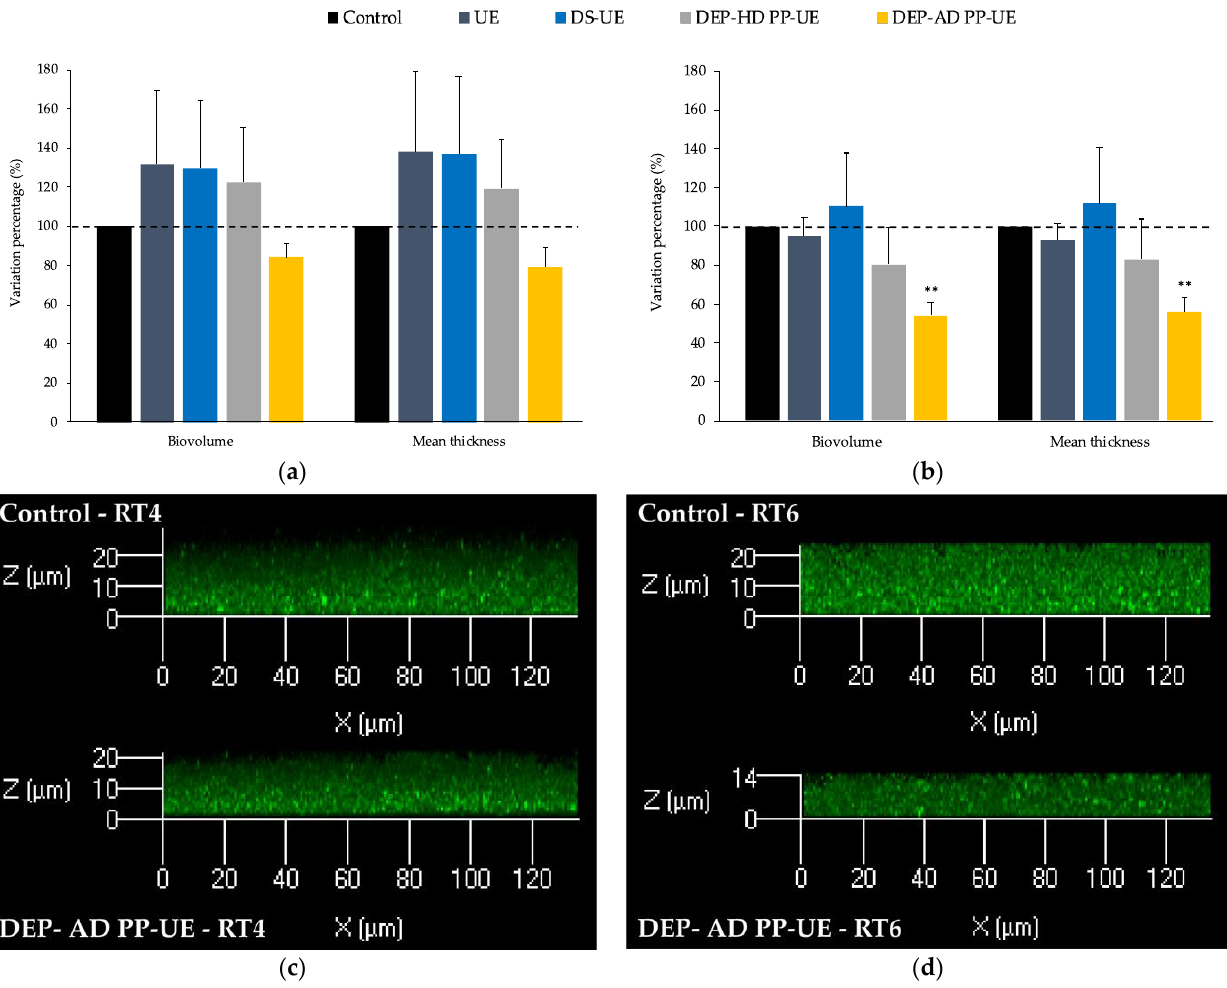
Figure 6. Effects of poly- and oligosaccharide Ulva sp. fractions at 1000 μg/ mL on the biofilm production of ( a ) C. acnes RT4 ( n = 4) and ( b ) C. acnes RT6 ( n = 4) evaluated by confocal laser scanning microscopy. Significant differences between the control (bacteria preliminarily cultured in medium alone) and after the bacteria were preliminarily cultured in a cultured medium in presence of the fractions are indicated by ** p < 0.01. ( c ) Representative views of X/Z sections of the biofilms formed in control conditions (RT4 preliminarily cultured in RCM pastone +2% glucose alone) and when RT4 were preliminarily cultured in RCM pastone +2% glucose in the presence of DEP-AD PP-UE at 1000 μg /mL. ( d ) Representative views of X/Z sections of the biofilms formed in control conditions (RT6 preliminarily cultured in RCM polypeptone +2% glucose alone) and when RT6 were preliminarily cultured in RCM polypeptone +2% glucose in the presence of DEP-AD PP-UE at 1000 μg/ mL.